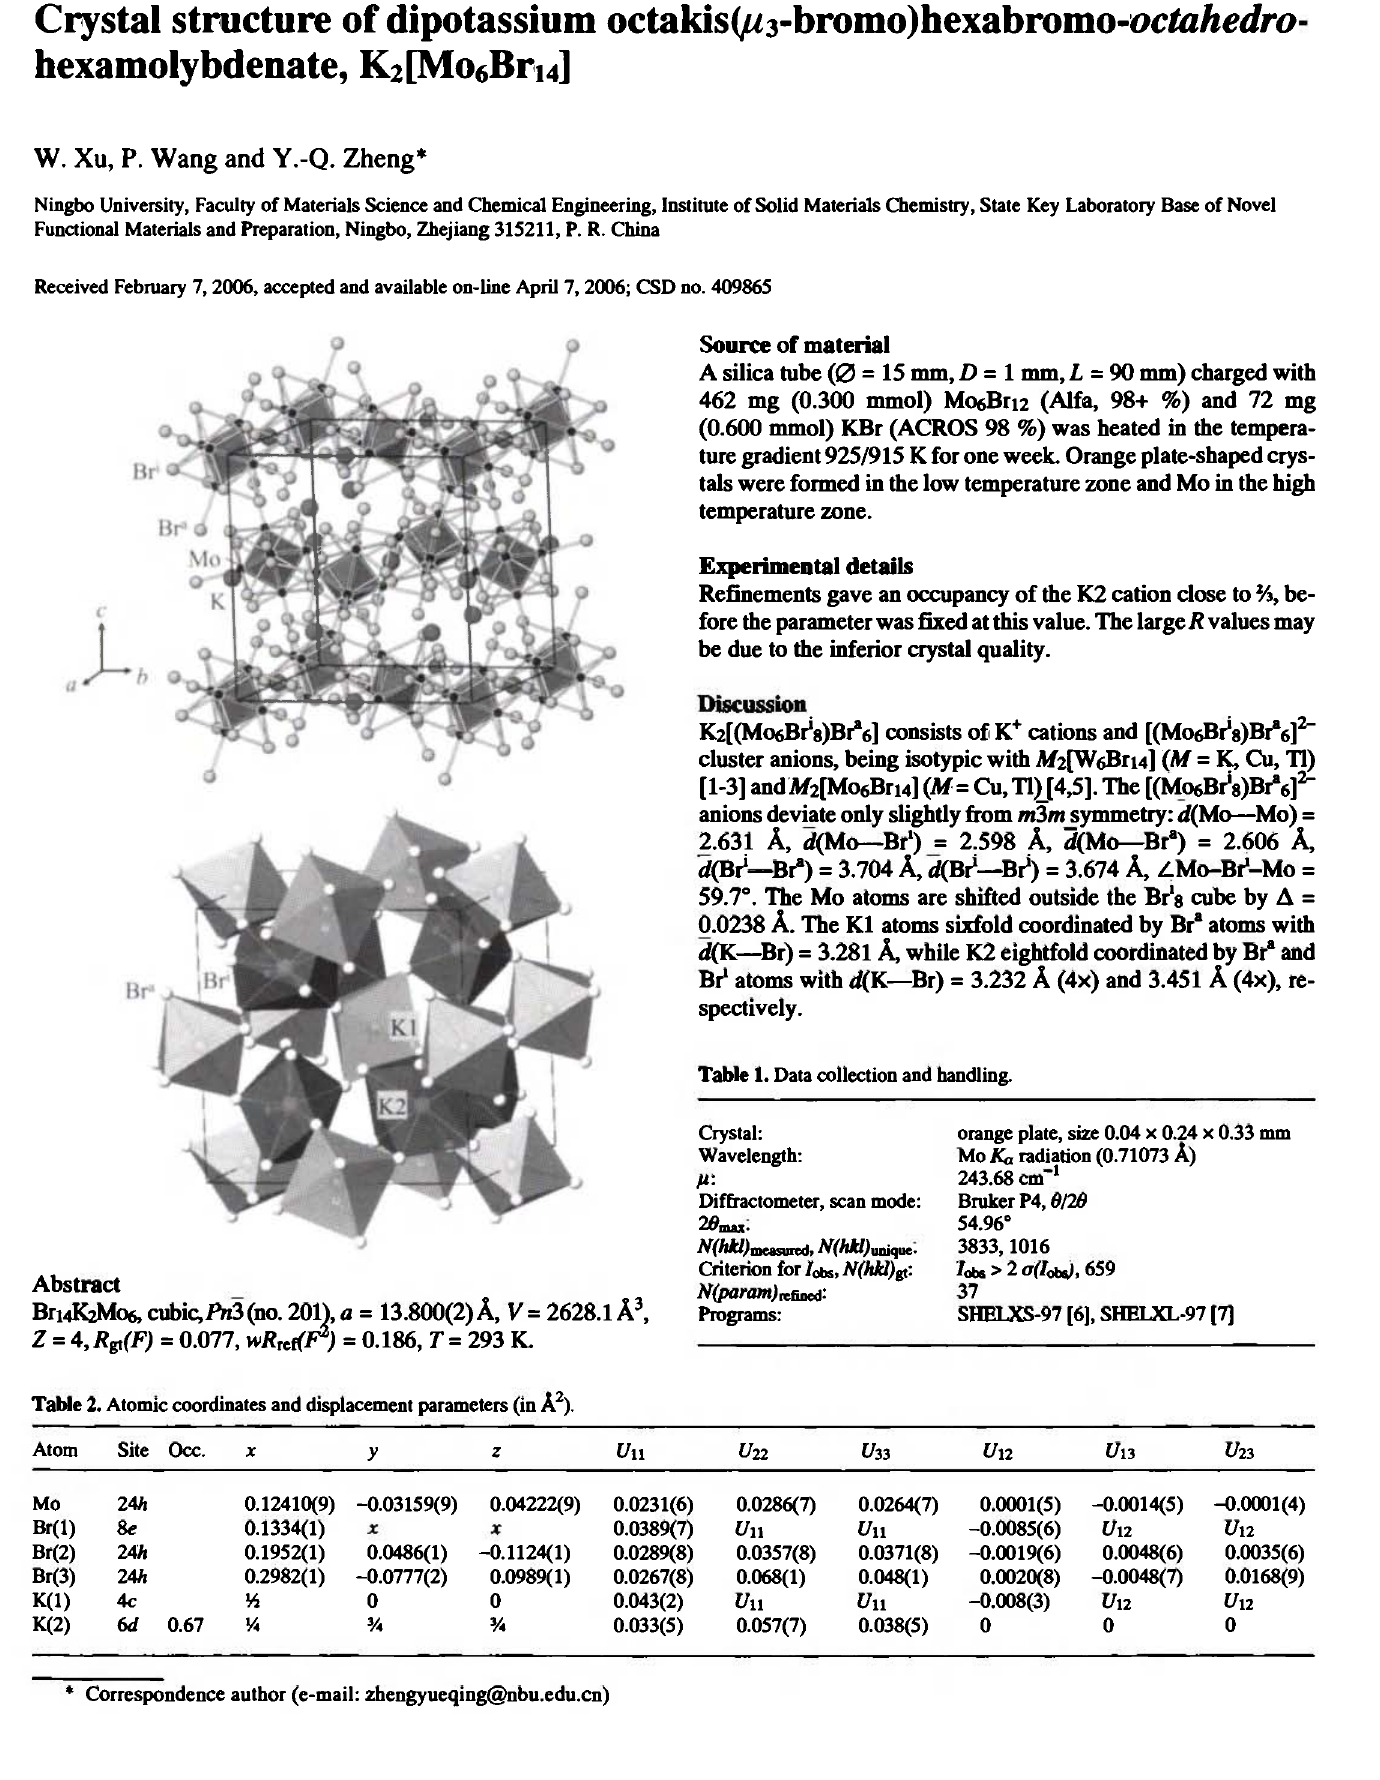
Table 2. Atomic coordinates and displacement parameters (in Ä 2